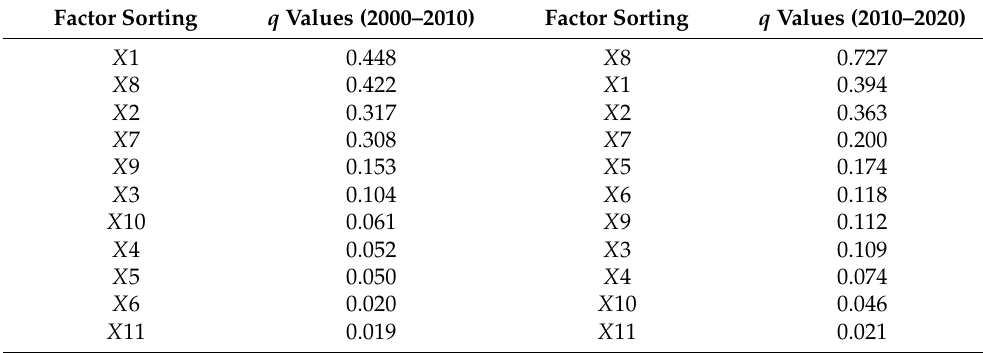
Table 4. Factor detection results of the cultivated land non-agriculturalization driving factors. Factor Sorting q Values (2000–2010) Factor